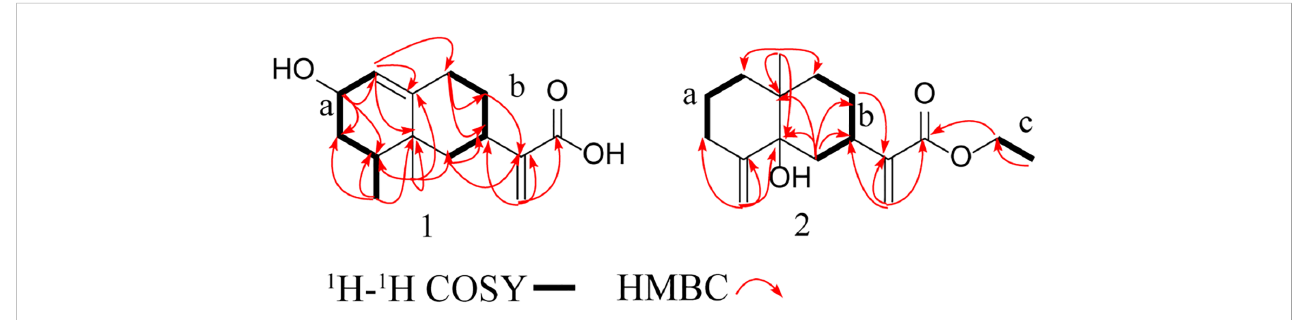
FIGURE 1 Key HMBC, 1 H-1 H COSY, and HMBC correlations of compounds 1 and